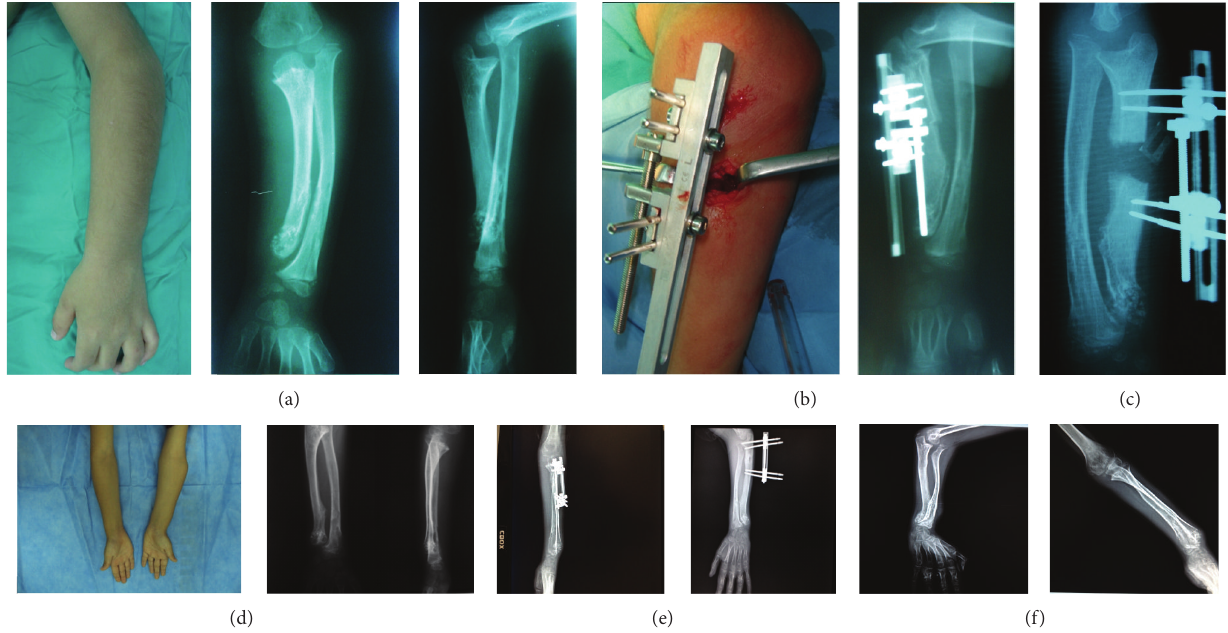
Figure 1: The preoperative, intraoperative, and postoperative images of the first case. (a) Preoperative and (b) intraoperative images of the first time of distraction, (c) 45 days of distraction osteogenesis, (d) clinical and radiographic images of patients after 2 years of distraction osteogenesis,(e)postoperativeimagesofpatientsafterseconddistractionosteogenesis,and(f)imagesofpatientsafterimplantswereremoved.